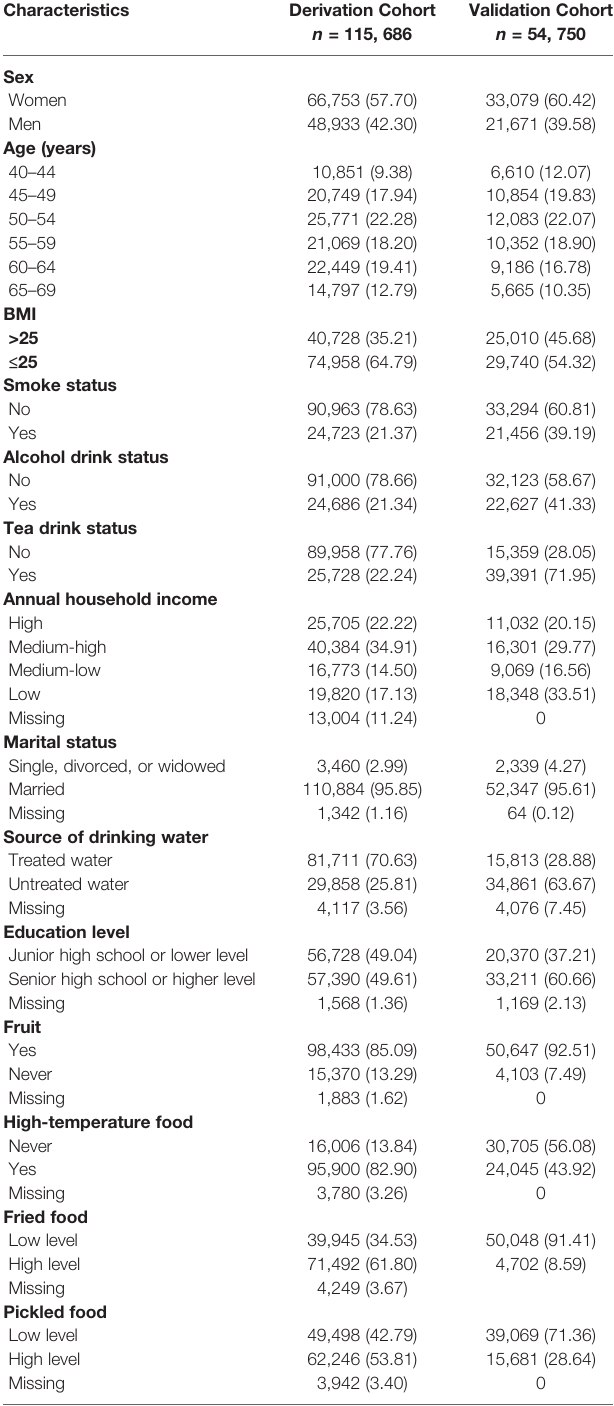
TABLE 1 | Baseline characteristics of participants in the derivation cohort and validation